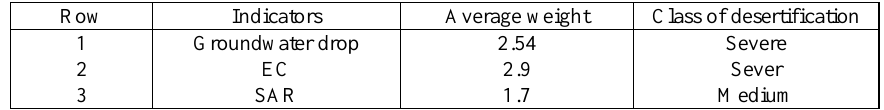
Table 1. Average weight of indicators affecting desertification based on water